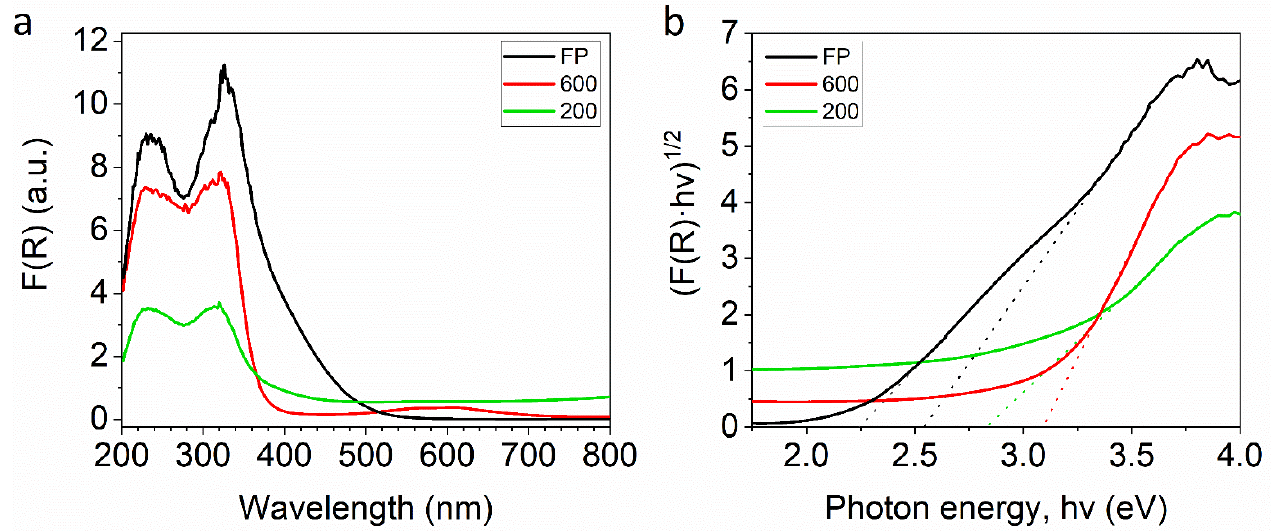
Figure 5. ( a ) Kubelka–Munk function spectra with ( b ) Tauc plot for estimating the bandgap energy for feedstock powder (black), sample 200 (green) and 600 (red).